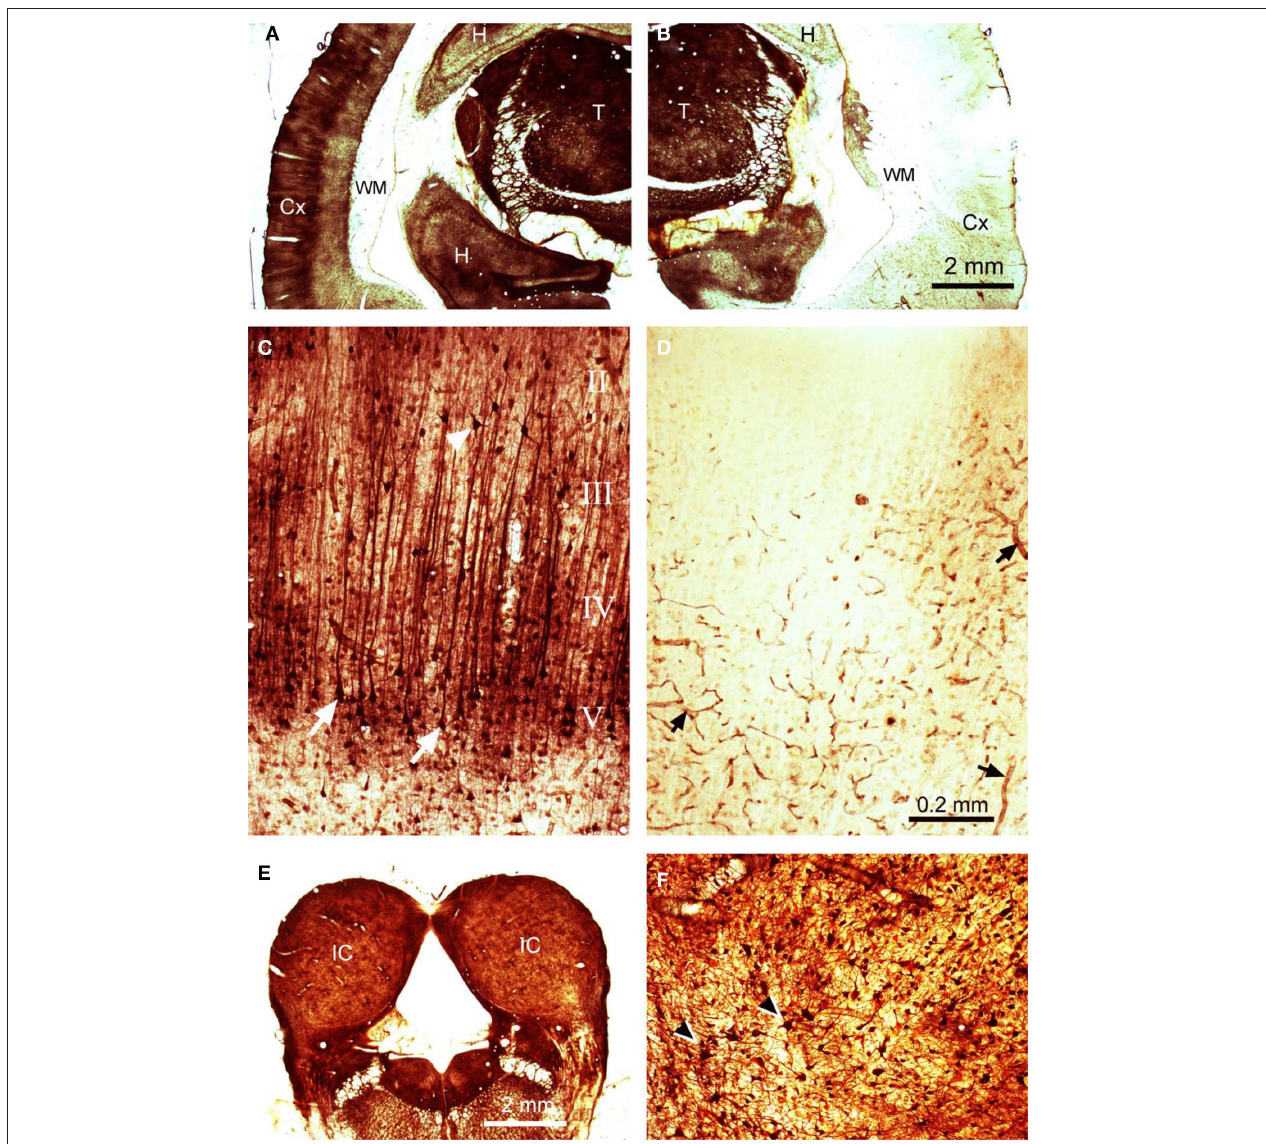
the neocortex, (C) left cortex at higher power showing prominent layer V pyramidal cells with dark apical dendrites, (D) right cortex at higher power showing an absence of neuronal labeling but darkly stained blood vessels, (e) right and left IC showing similar levels of staining, (F) stained neurones in the IC at a higher power. The magnification is the same for panels (A) , (B) , and (e) and for (C) , (D) , and (F)